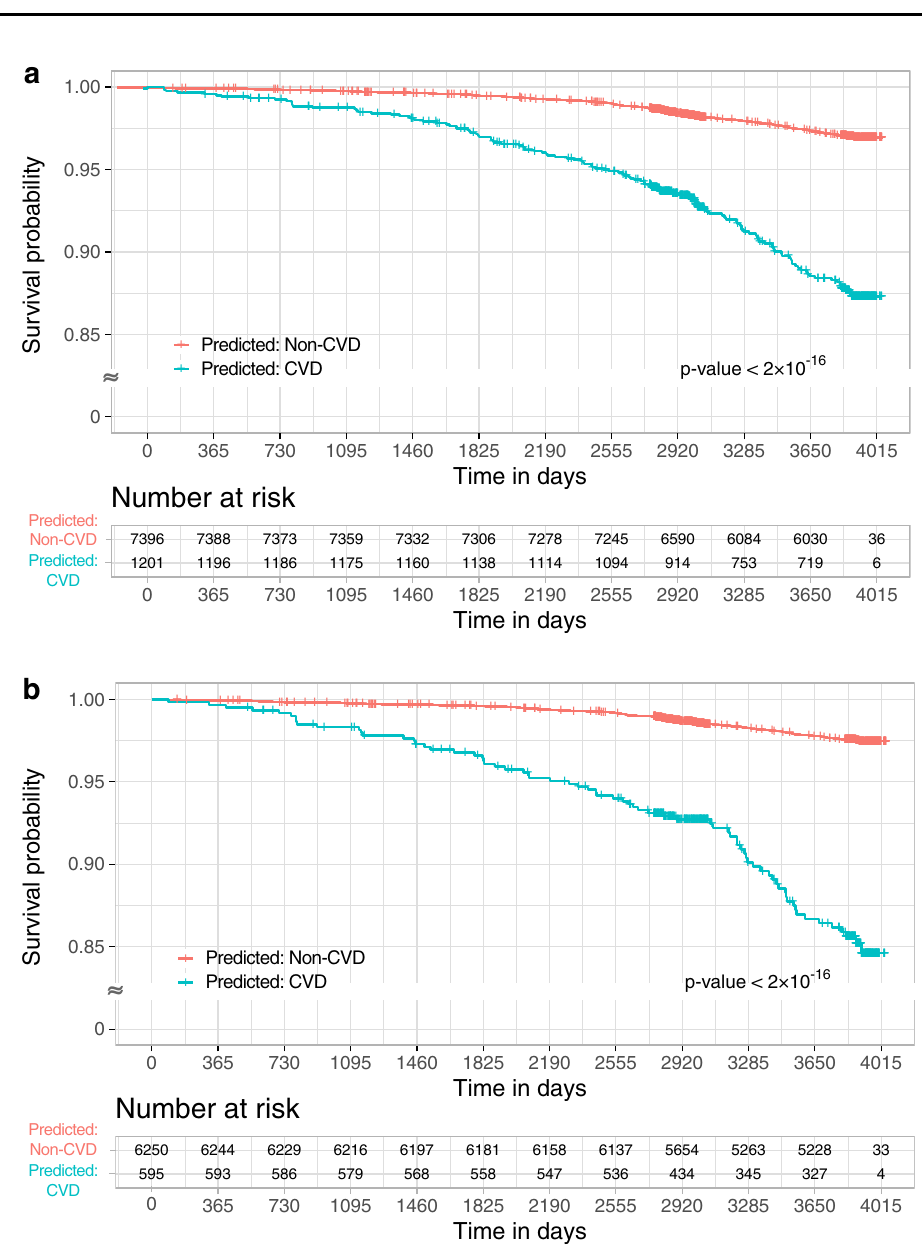
Fig. 5 Association of predicted risk with incident CVD. Kaplan – Meier graphs for incident CVD in the at-risk patients according to the predicted class from Model 10 ( a ) and Model 11 ( b ). CVD cardiovascular